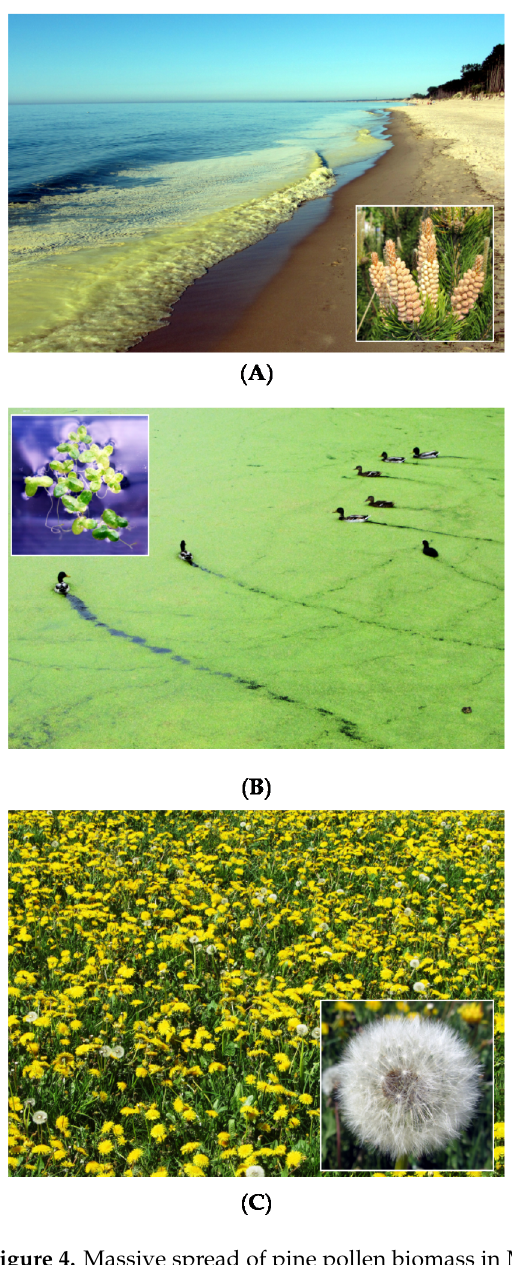
Figure 4. Massive spread of pine pollen biomass in May along Baltic Sea shore ( A ), duckweed ( B ) plants in Poland, dandelion ( C ).